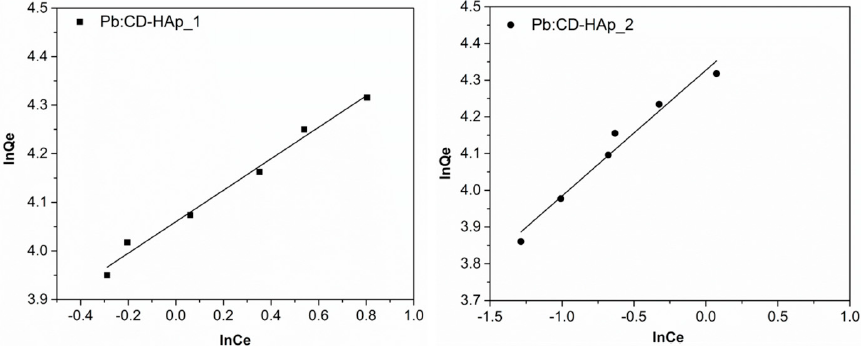
Figure 9. Freundlich linearized fits for the adsorption of lead CD-HAp_1 and CD-HAp_2 samples. Table 2. Isotherms parameters for lead adsorption onto CD-HAp_1 and